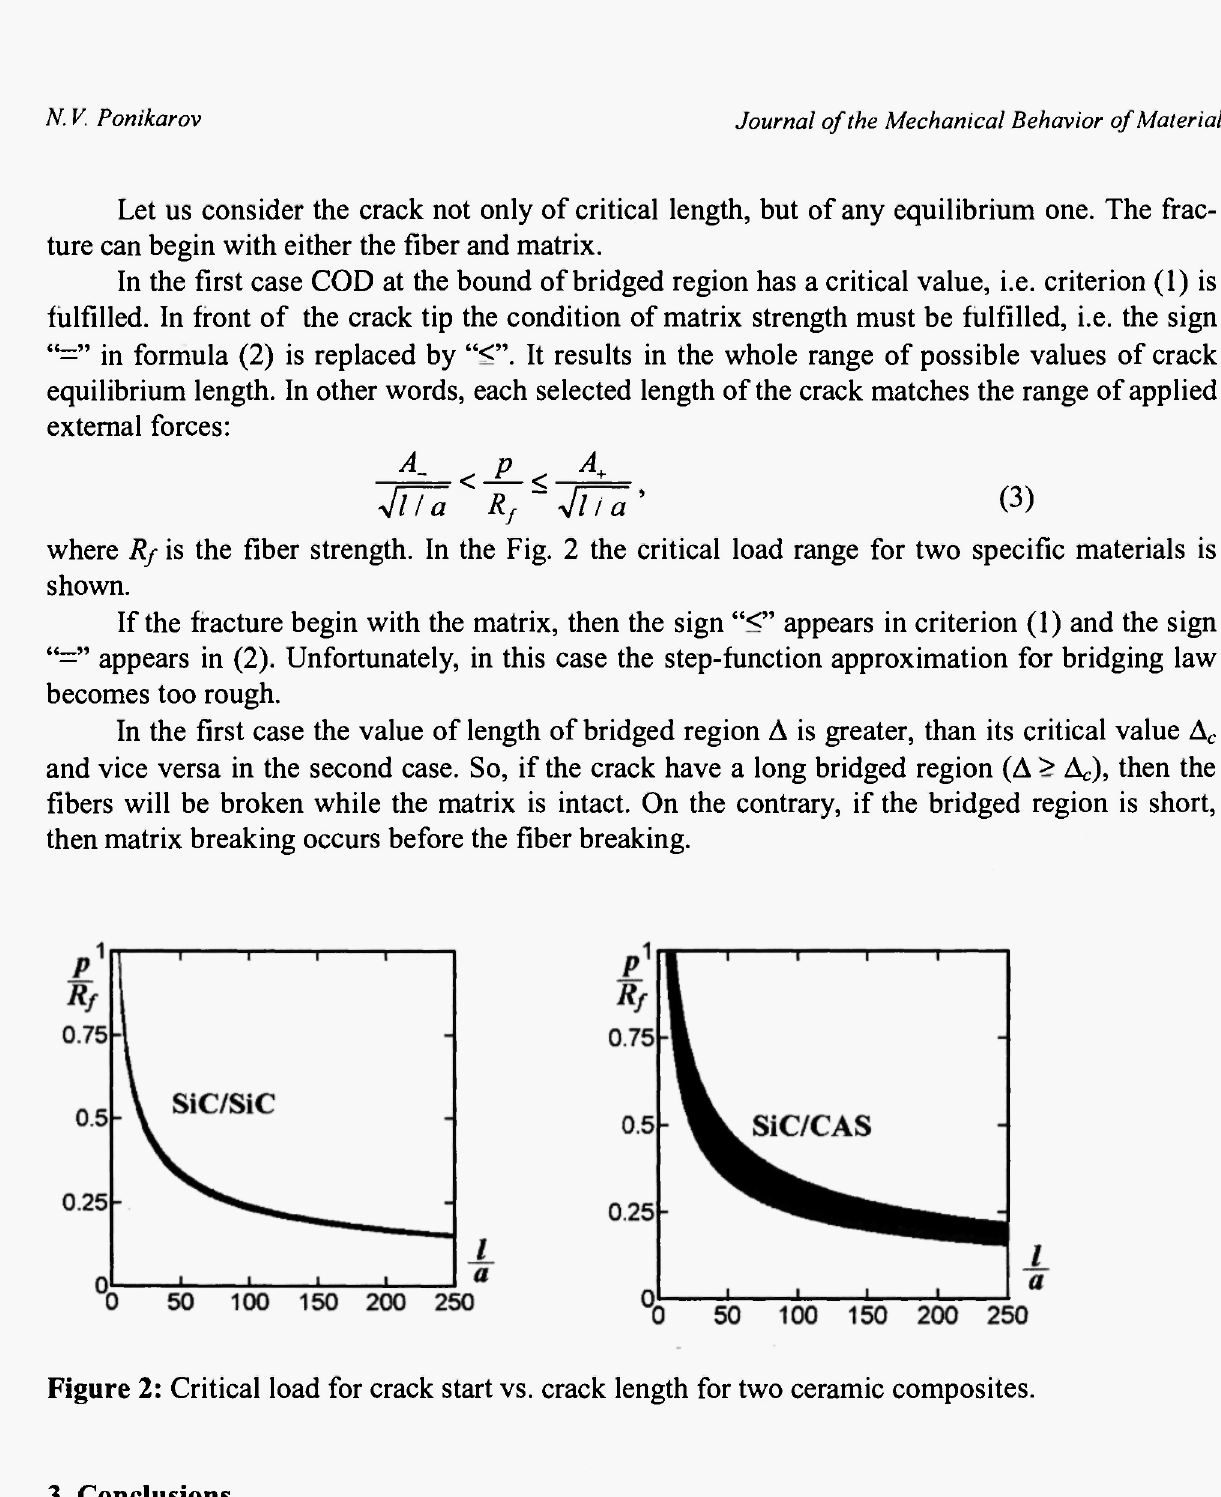
Figure 2: Critical load for crack start vs. crack length for two ceramic